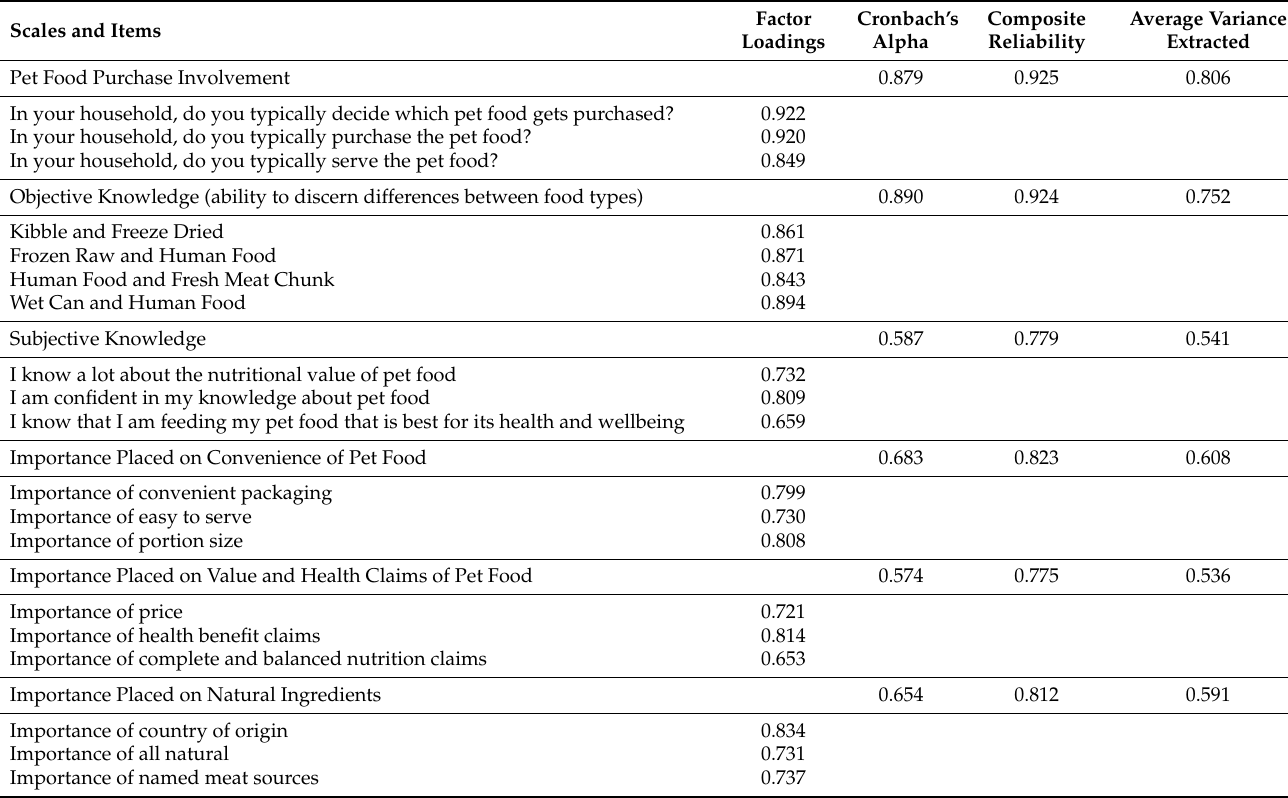
Table 2. Assessment of the outer model: scale loadings, reliabilities, and convergent validity.